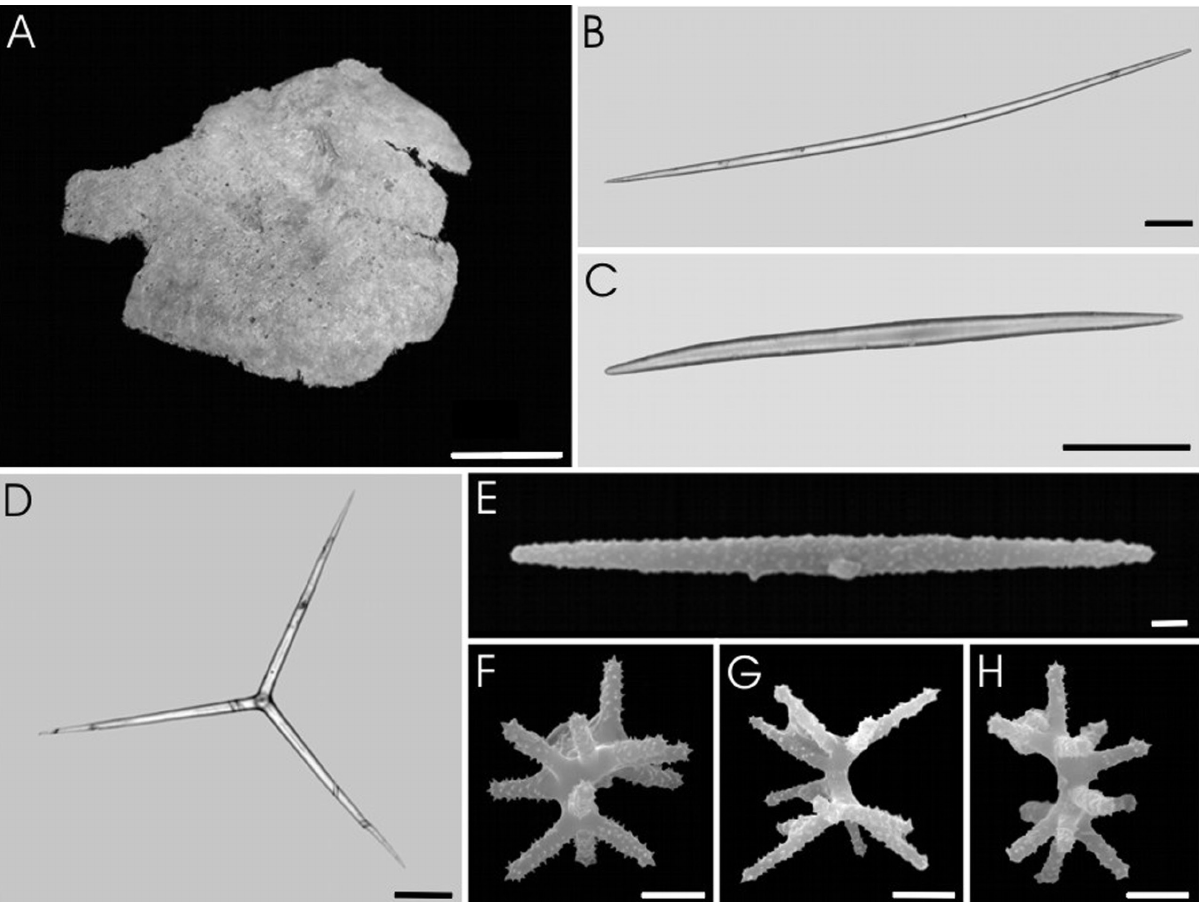
Fig . 2. – Poecillastra antonbruunae n. sp. A, schizotype (MNRJ 9645). B, Oxea I. C, Oxea II. D, Calthrops. E, Acanthomicroxea. F-H, Spirasters. Scale: A, 1 cm; B-D, 100 µm; E-H, 5